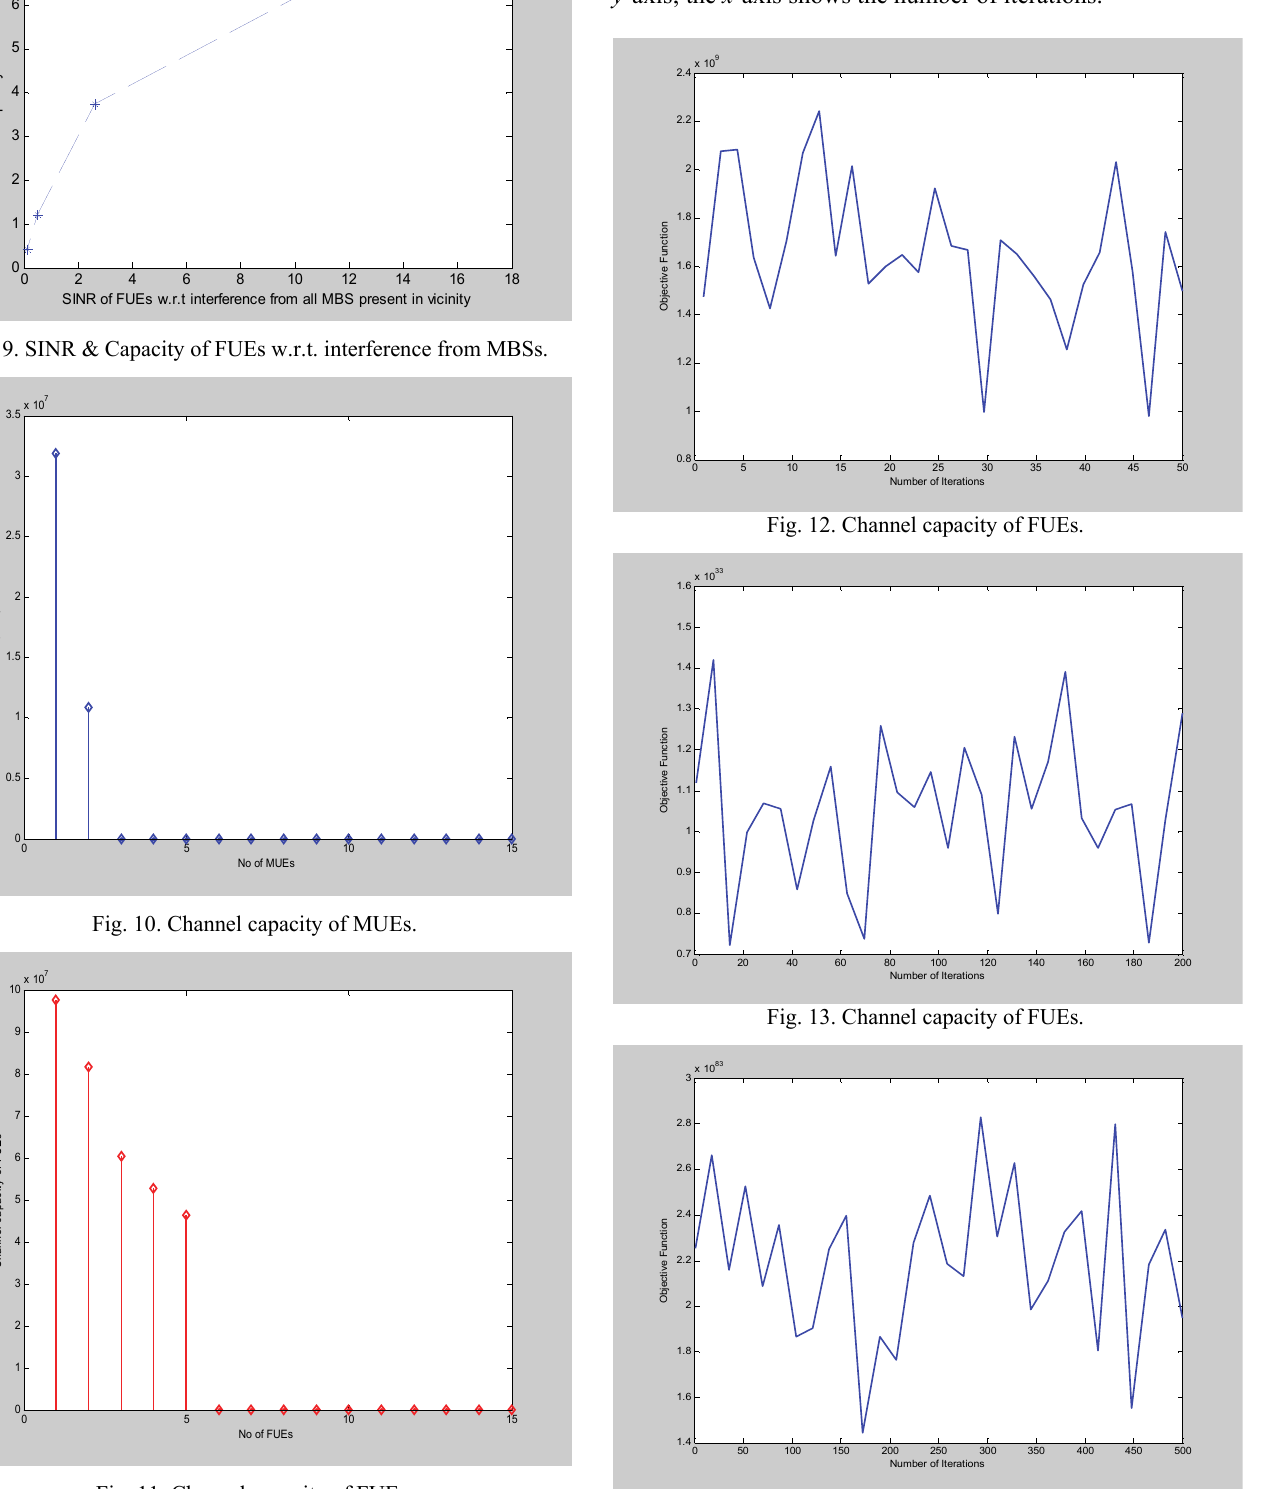
Fig. 14. Channel capacity of